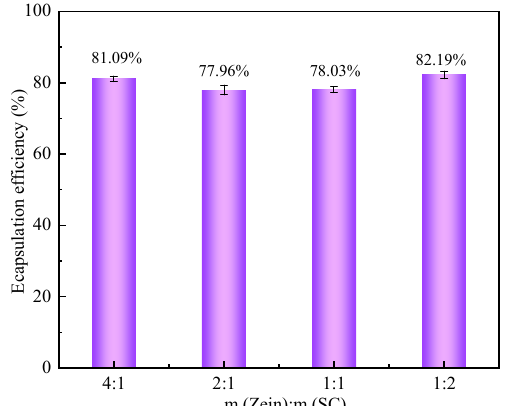
Figure 2. The EE of CA-loaded composite NPs with different zein/SC mass ratio (1:2, 1:1, 2:1, and 4:1).